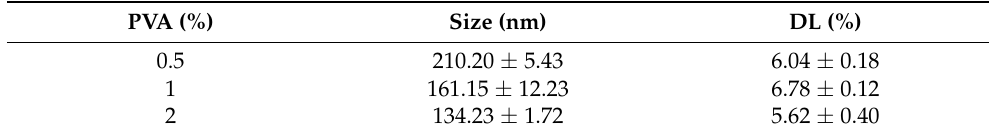
Table 2. Effect of the concentration of PVA on DL.